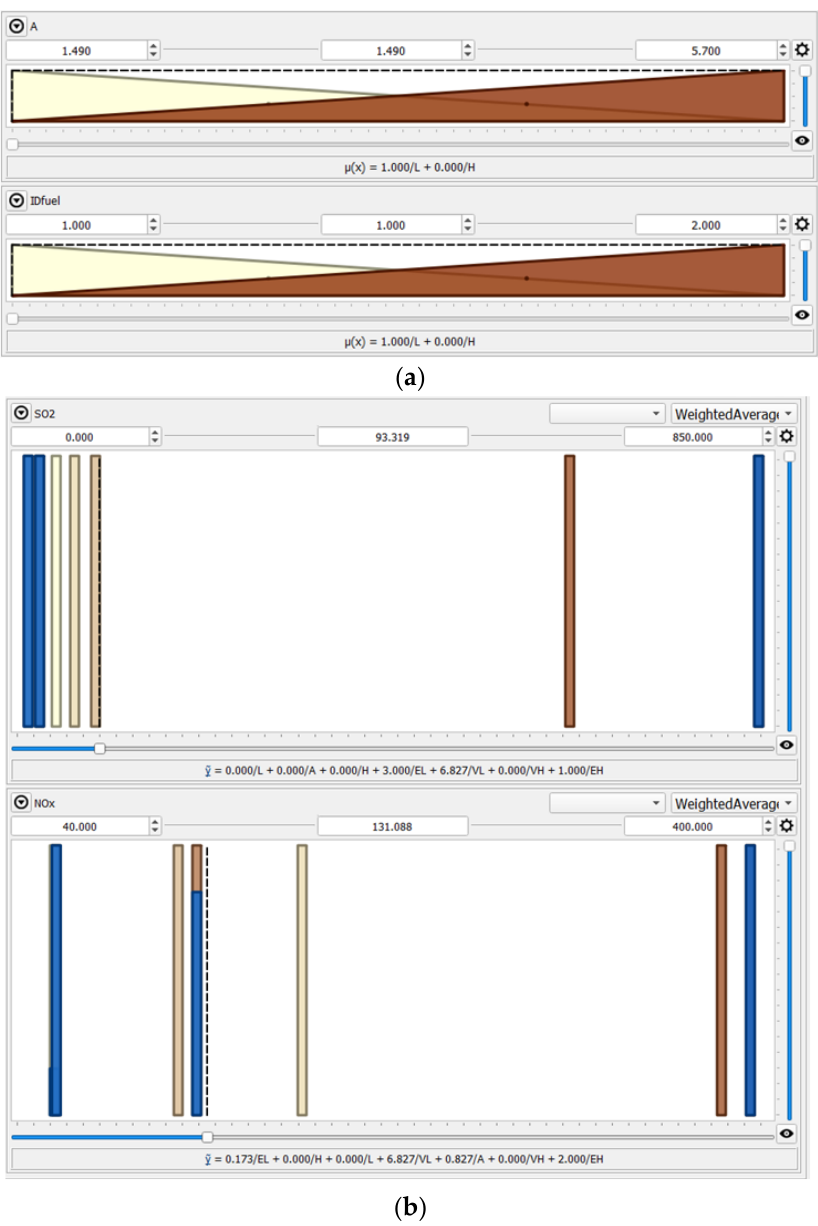
Figure 5. The FL model with graphical representations of input ( a ) and output ( b ) variables. Table 4. The IF-THEN rule-base of the model for (a) SO 2 and (b) NO x . (a)